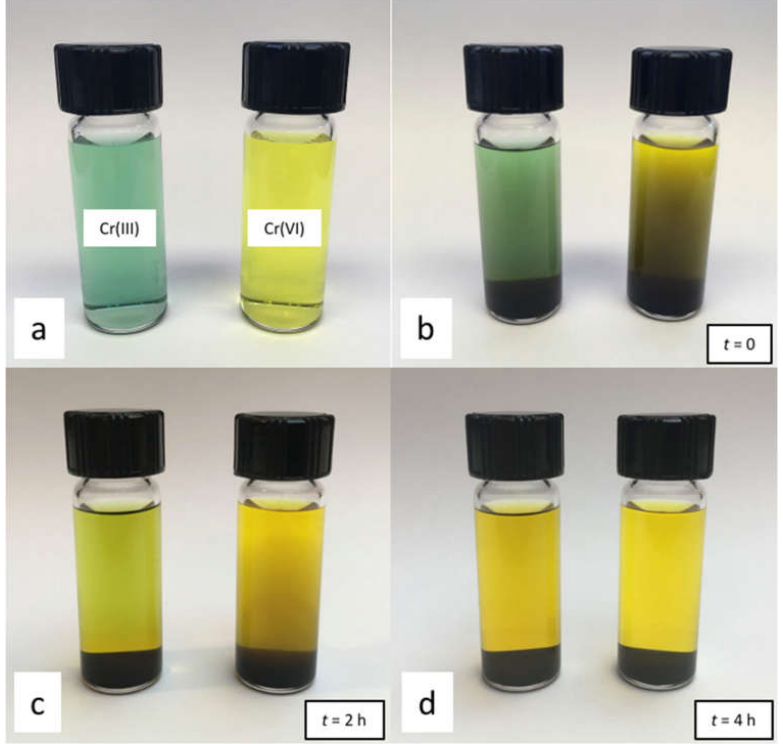
Figure 7. Images of the reaction of Cr(III) and Cr(VI) with MnO 2 , showing ( a ) 20 mM Cr(III) and Cr(VI), ( b ) the addition of 0.50 g MnO 2 at ( t = 0), and the reaction mixtures after ( c ) 2 h and ( d ) 4 h.